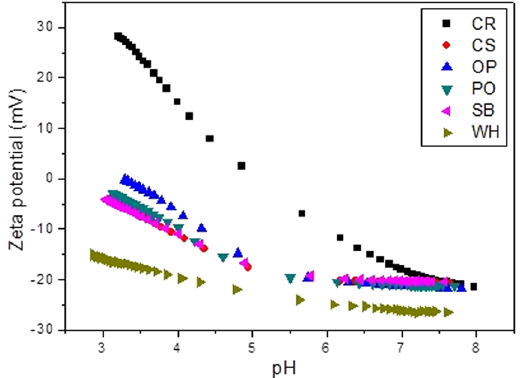
Figure 2. Zeta potentials of the biochar samples: CR = charcoal fines; CS = coconut shell; OP = orange peel; PO = palm oil bunch; SB = sugarcane bagasse; WH = water